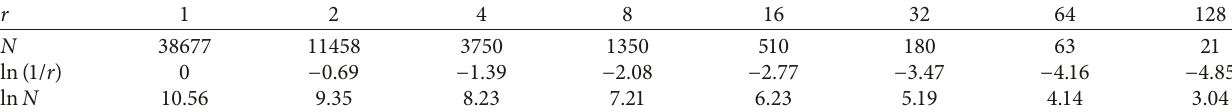
(mining face 5-1 at a mining length of 1500mm). f